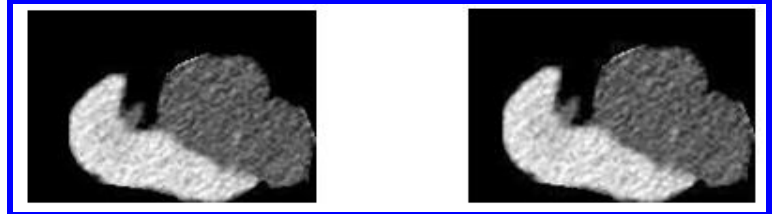
Fig. 3: Conversion from RGB to grayscale image.